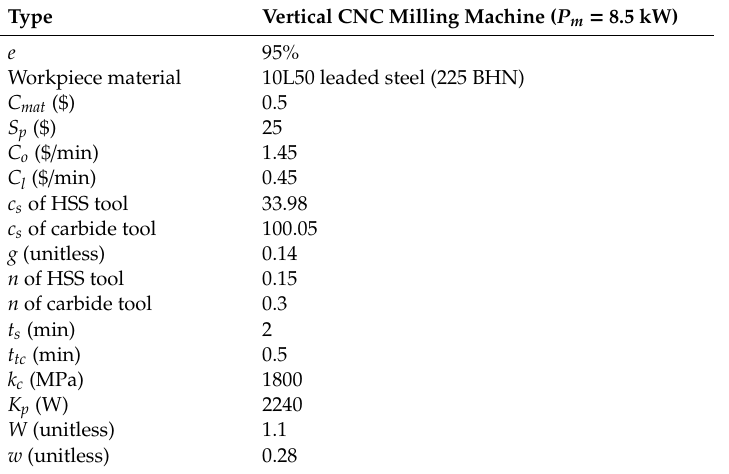
Table 2. Parameters for case study [7].